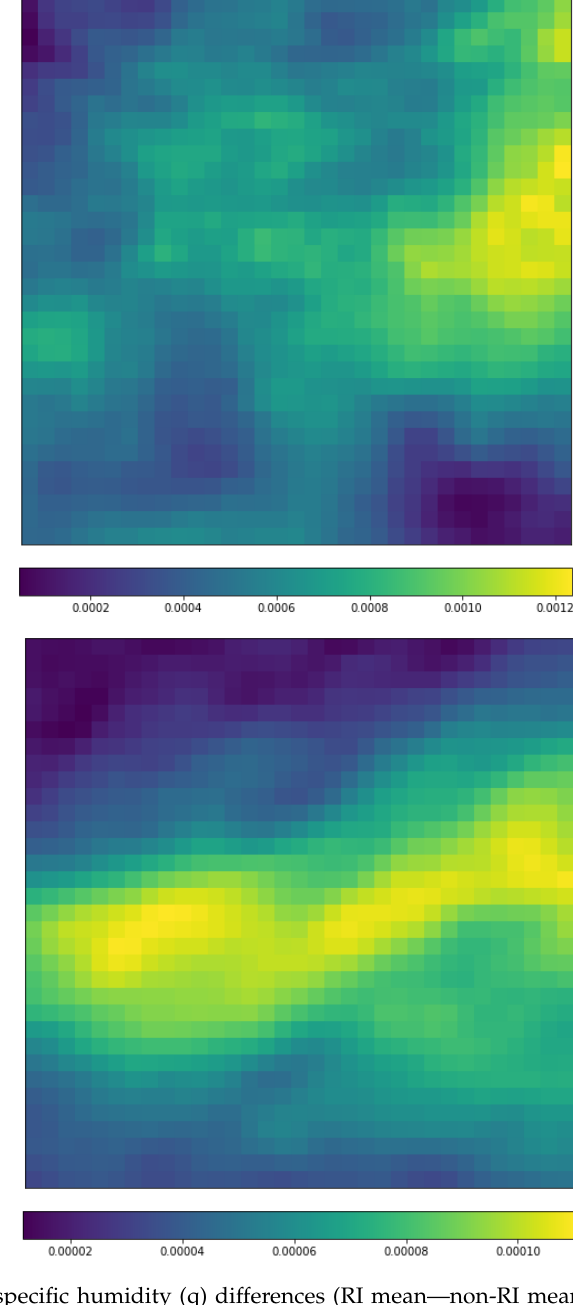
Figure 9. Distribution of mean specific humidity (q) differences (RI mean—non-RI mean) (unit: kg/kg) between the 584 RI cases and randomly selected 584 non-RI samples at ( left -to- right , top -to- bottom ) 850 hPa, 700 hPa, 500 hPa, and 300 hPa, respectively (in that order). The X-axis and Y-Axis are aligned as in Figure 8.